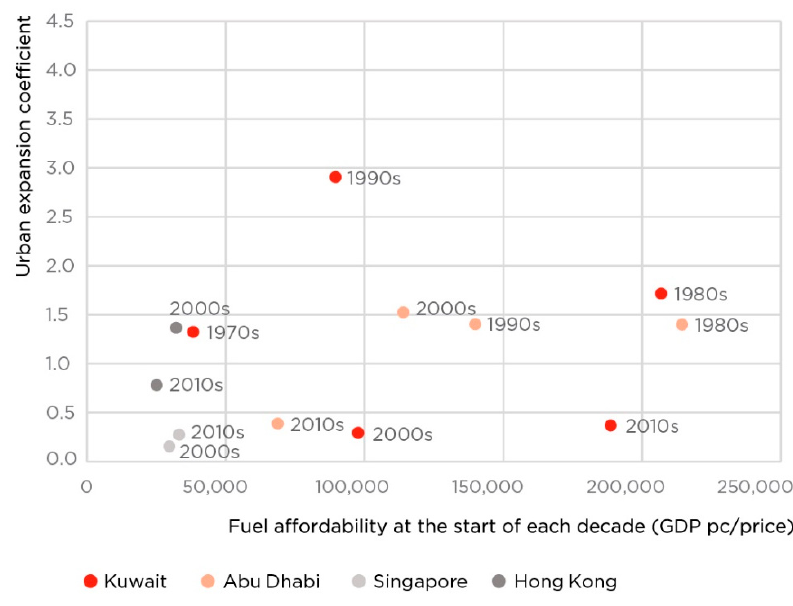
ff ordability and urban expansion by Figure 5. Fuel affordability and urban expansion by decade. Figure 5. Fuel a